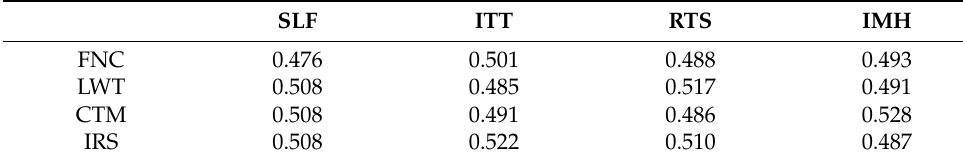
Table A16. Normalized matrix.